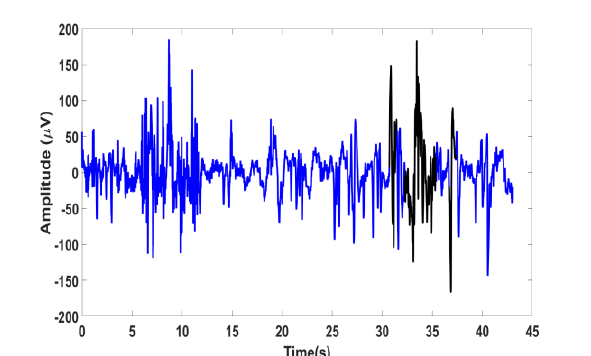
Figure 9. EEG signal in one of the channels, filtered by a Butterworth filter of the 8th order and notch